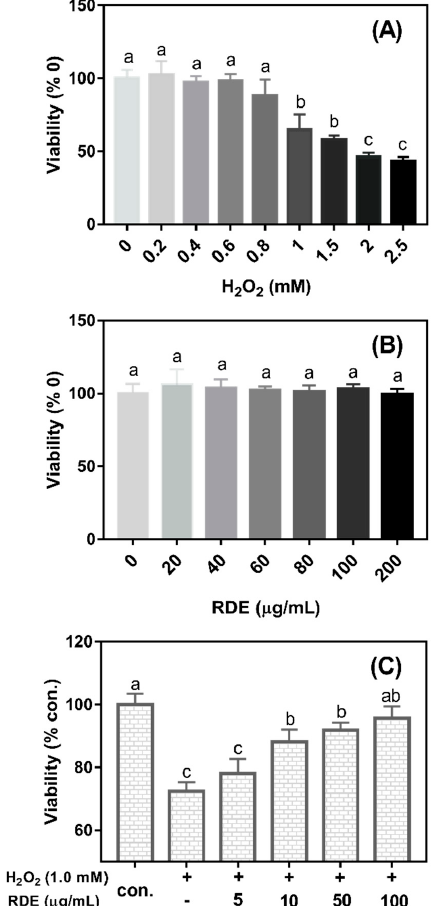
Figure 1. E ff ect of H 2 O 2 and red-osier dogwood extracts (RDE) on the cell viability of Caco-2 cells. ( A ) Cells were treated with di ff erent concentrations of H 2 O 2 for 24 h, and then cell viability was detected. ( B ) Cells were treated with RDE for 24 h, and then cell viability was detected. ( C ) Cells were treated with 1.0 mM H 2 O 2 for 3 h, and then treated with a medium containing di ff erent RDE concentrations for 24 h. Cells were seeded in a 96 well plate at a density of 2 × 10 4 / well and cultured for 5 d. Cell viability was expressed as a percentage of control (without H 2 O 2 and RDE). The data were presented as mean ± SD, n = 5. Di ff erent lower case letters indicate a significant di ff erence at P <